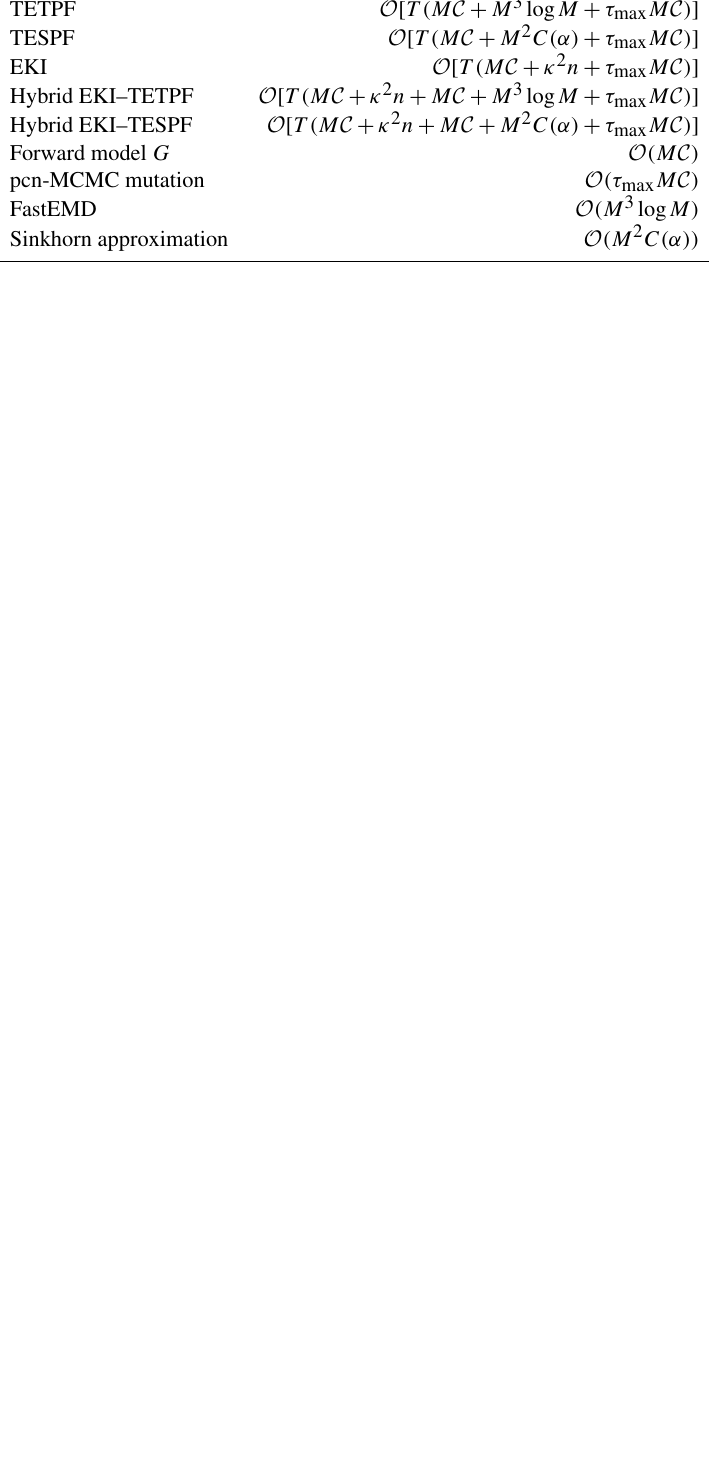
Table B1. The table provides an overview of the computational complexity of all the algorithms considered in the paper.